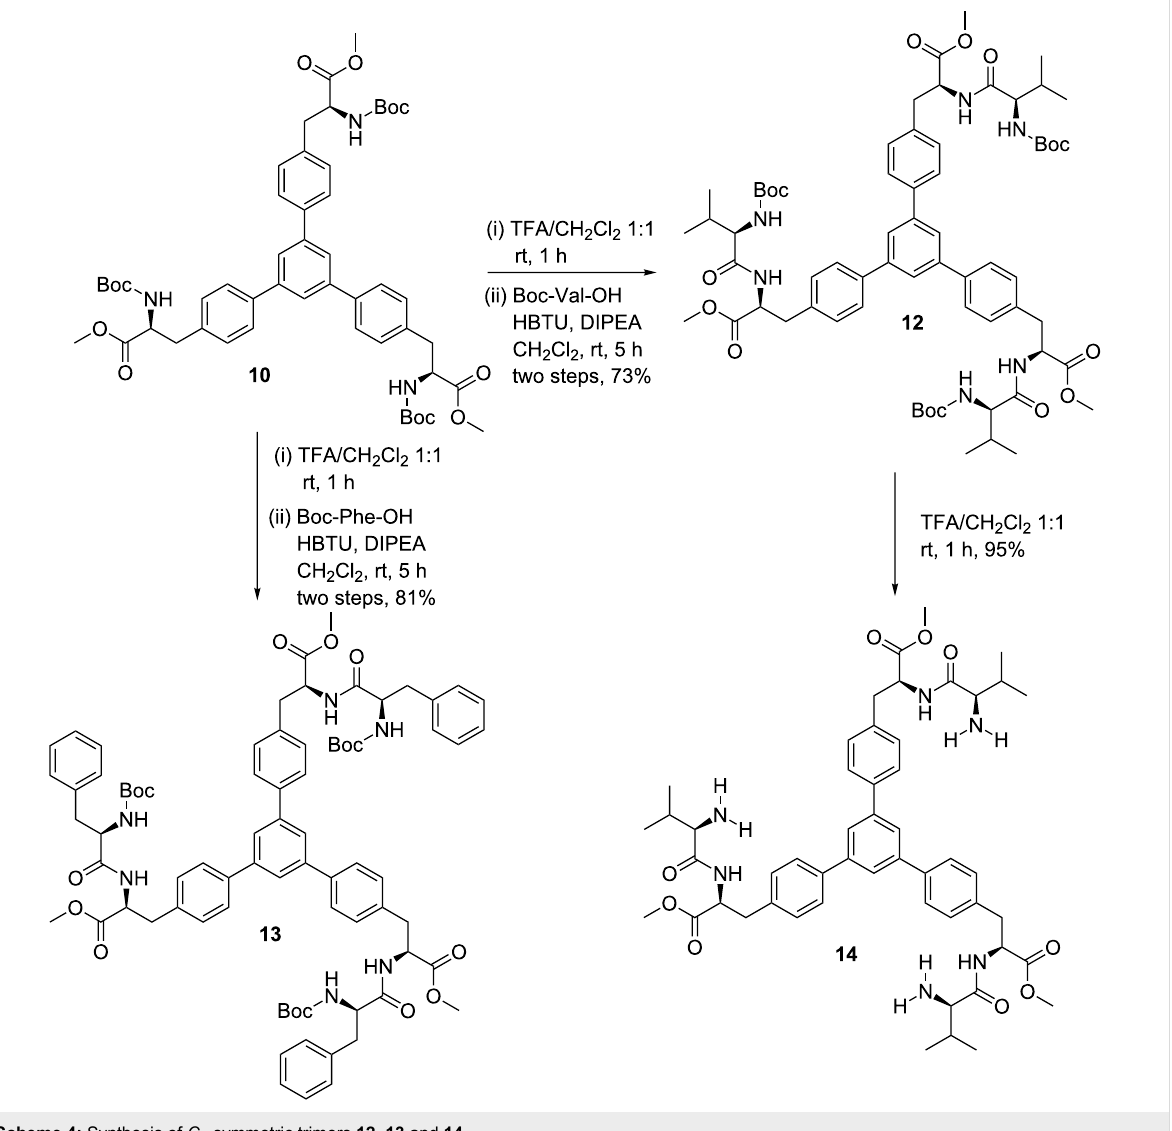
Scheme 4: Synthesis of C 3 -symmetric trimers 12 , 13 and 14 .